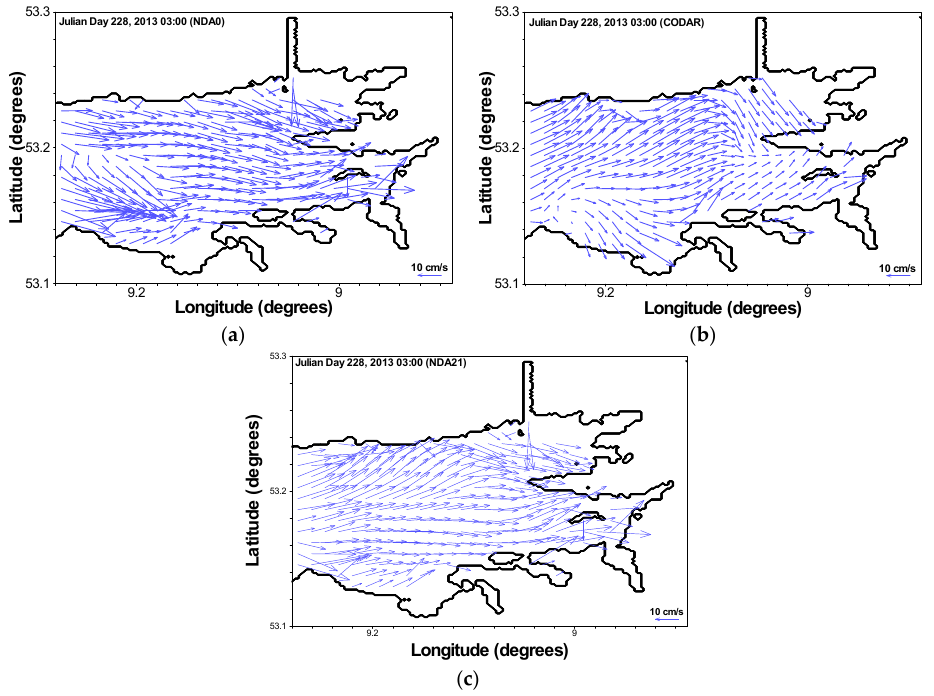
Figure 10. Surface flow fields at 03:00 Julian Day 228 (( a ) forecast from the model NDA0; ( b ) radar data; ( c ) forecast from the model NDA21).